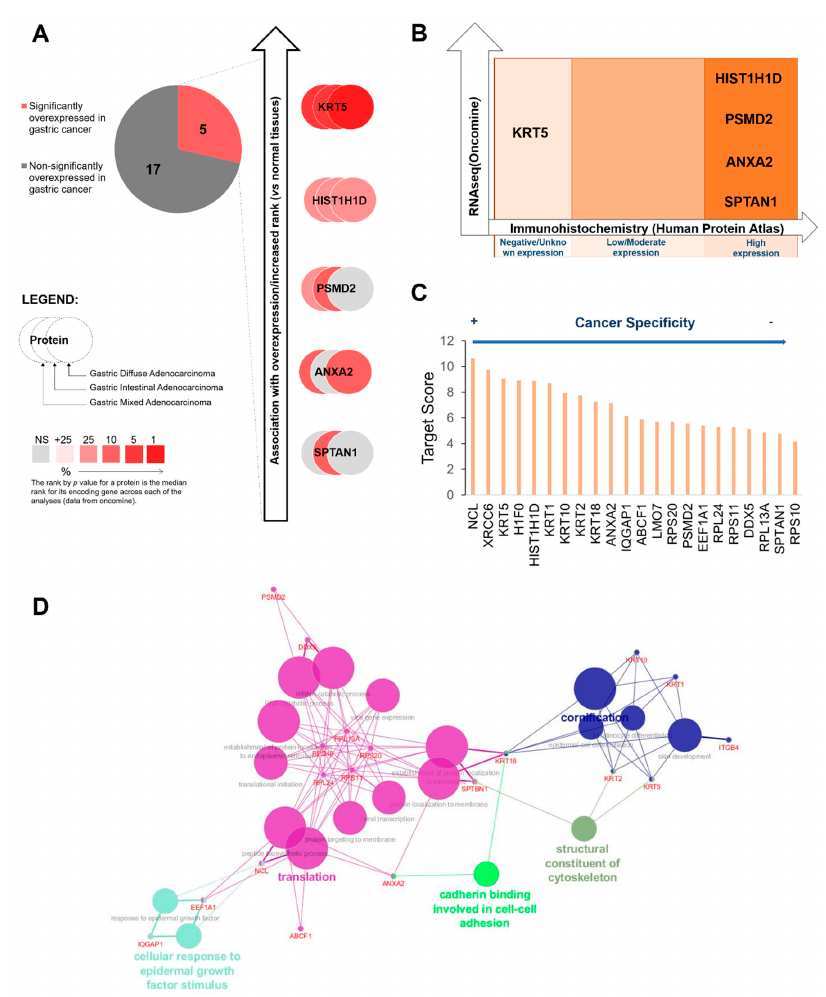
Figure 4. Bioinformatics analysis of the 22 glycoproteins expressing SLeA and showing affinity to E-selectin that were present in all cell lines towards biomarker discovery. ( A ) Identification of glycoproteins showing elevated gene expression. The 22 glycoproteins set was comprehensively matched against existing transcriptomics data in the Oncomine database. Only five have previously been reported to be overexpressed in GC, occurring throughout intestinal, mixed and diffuse type lesions as highlighted in the right. Notably, KRT5 and HIST1H1D were significantly overexpressed in all types, PSMD2 was mainly associated with the intestinal and mixed phenotype, ANXA2 was linked to intestinal and di ff use type but not mixed lesions, whereas SPTAN1 was overexpressed solely in mixed type lesions. ( B ) Comparison between transcripts and protein levels for the identified glycoproteins. Transcriptomics findings (RNAseq; Oncomine) were matched against protein expression in GC (immunohistochemistry, Human Protein Atlas). KRT5 showed low / no expression at the protein level, thus not reflecting increased transcriptional activity. HIST1H1D, PSMD2, ANXA2 and SPTAN1 showed both increased gene expression and high protein levels in GC. ( C ) Target score for the identified glycoproteins in GC. Briefly, higher target scores are given to glycoproteins highly expressed at the cell membrane in cancer cells and showing low levels of expression in healthy tissues. Aspects related with poor prognosis significantly contribute to increase the scoring potential. Sub-cellular re-localization of proteins from intracellular compartments in healthy cells to the cancer cell membrane, an aspect that frequently occurs in cancer, is also highly score. Conversely, proteins showing a high expression in multiple healthy tissues are penalized in comparison to those showing a more cancer-specific expression pattern. According to this protocol, NCL (that was not found overexpressed in cancer tissues) ranked first as a potentially targetable biomarker due to its cancer specific nature. ( D ) Protein–protein networks highlighting the main biological functions played by the identified glycoproteins. The map demonstrates a significant functional correlation of identified glycoproteins with cell di ff erentiation, cytoskeleton organization, cell–cell adhesion mediated by cadherins, as well as translation and mediation of responses to epidermal growth factor stimulus. Notably, NCL appears to play a key role in the latter two